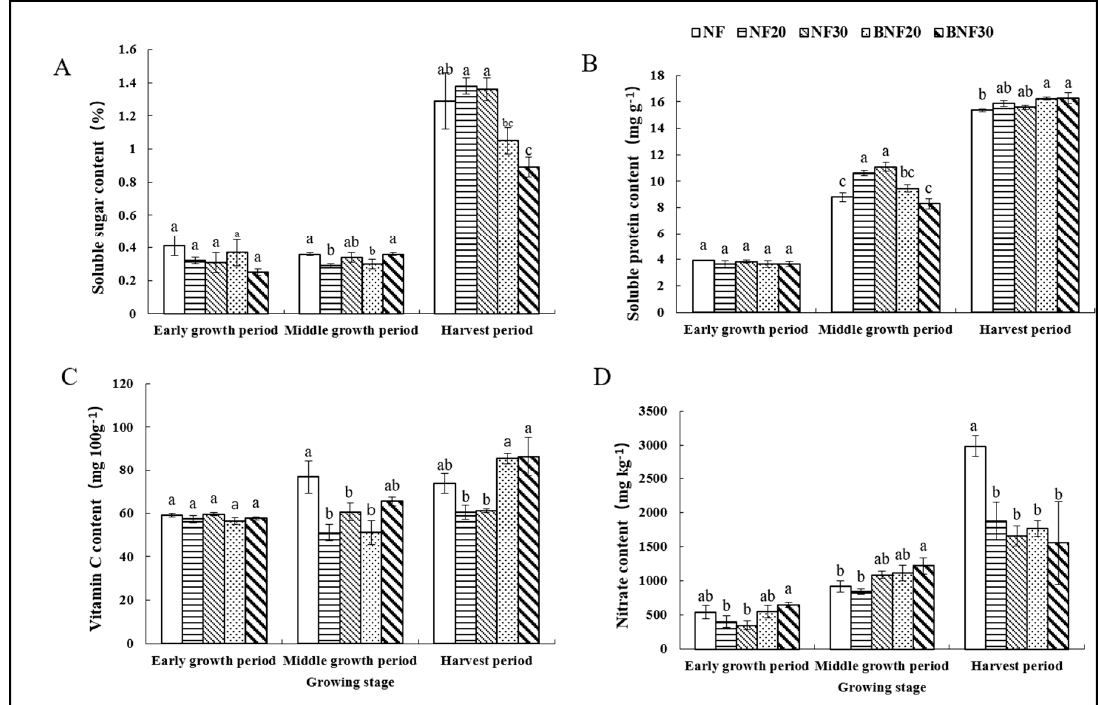
Figure 3. Effects of different fertilization treatments on leaf quality of non-heading Chinese cabbage at different growth stages: ( A ) soluble sugar content; ( B ) soluble protein content; ( C ) vitamin C content ( D ) nitrate content.